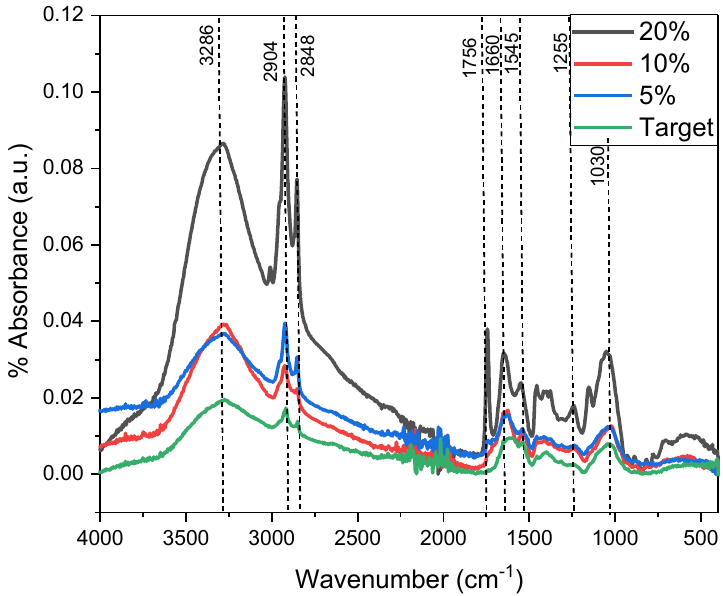
Figure 4. FTIR spectrophotometry of the papaya residues with saccharose. Table 1. BLAST characterization of the rDNA sequence of bacteria isolated from the MFCs anode